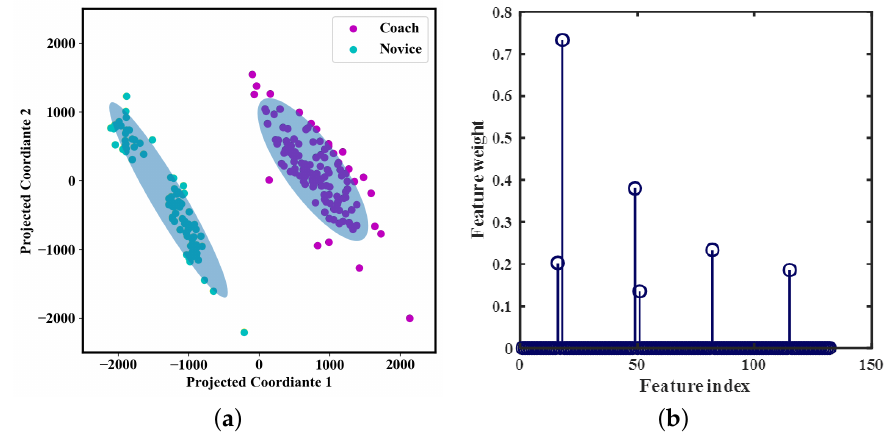
Figure 17. Principal component analysis (PCA) results and feature selection results. ( a ) the scatter plot of principal component analysis. ( b ) a plot of feature selection by Neighborhood component analysis